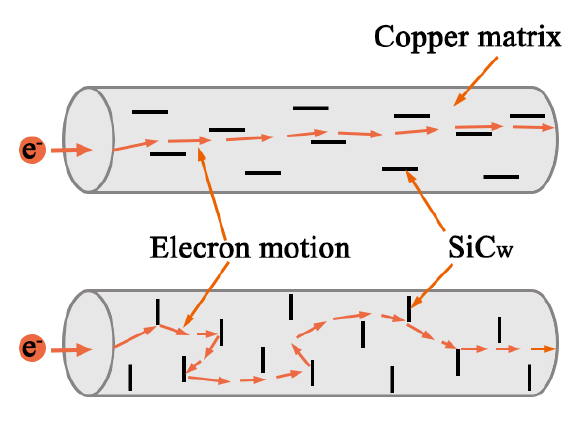
Figure 7: Schematic representation of the electron path through the SiC w /Cu composite conductor under the action of an electric field